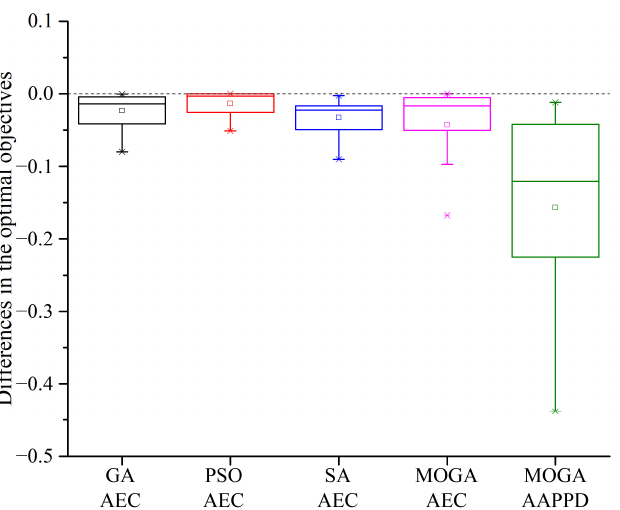
Figure 10. Illustration of the differences in the optimal objectives when the test algorithms use the optimal HPSs and the default ones.